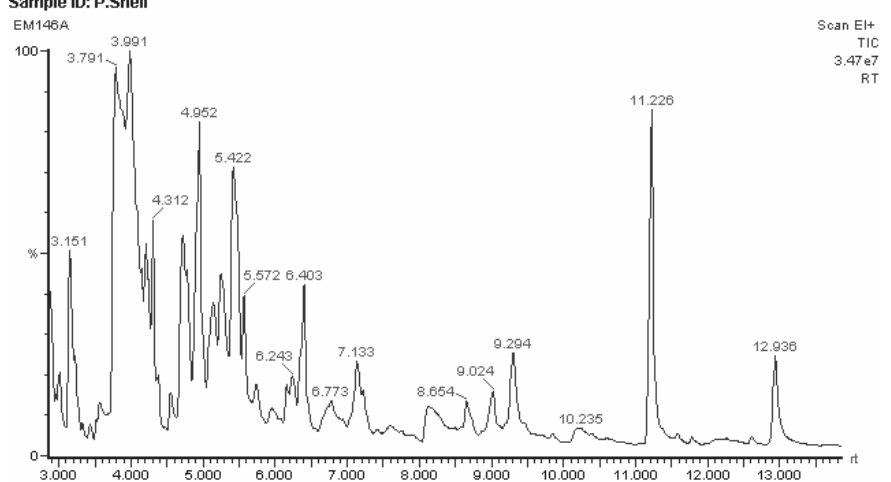
Figure 1 . Total Ion Chromatogram resulting from the aqueous distillate of palmyra palm shell extract obtained by destructive